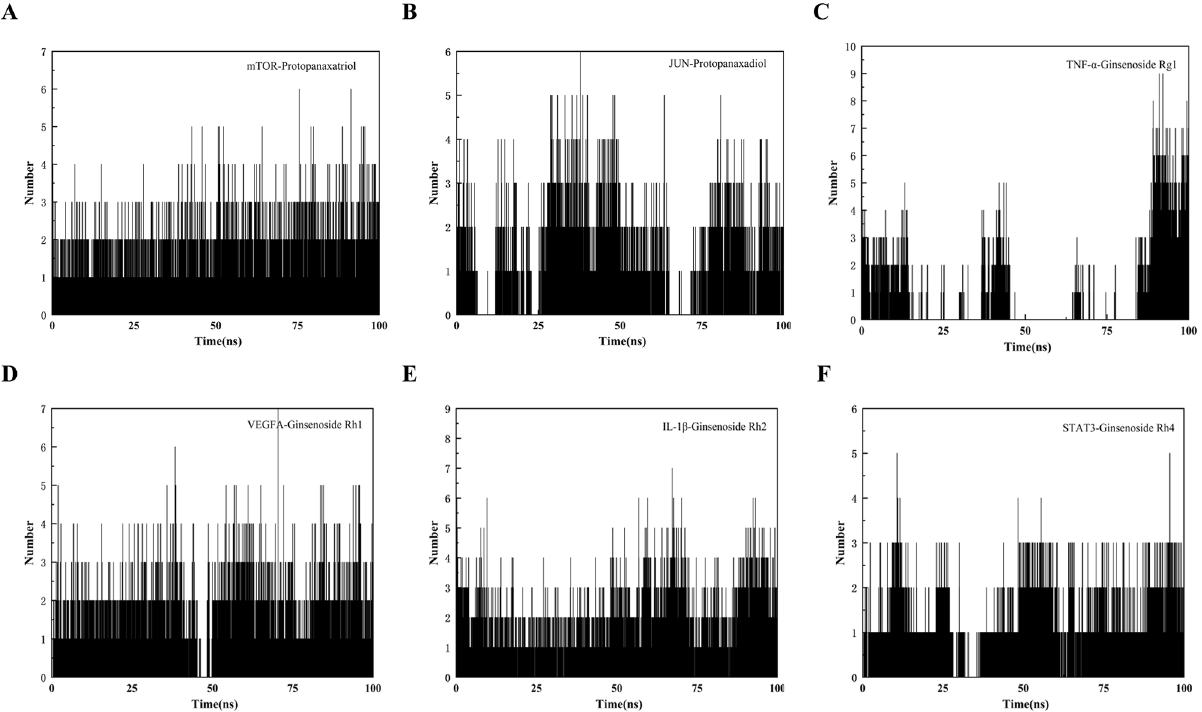
Figure 7. The number of hydrogen bonds involved in the binding of proteins with molecules during molecular dynamics